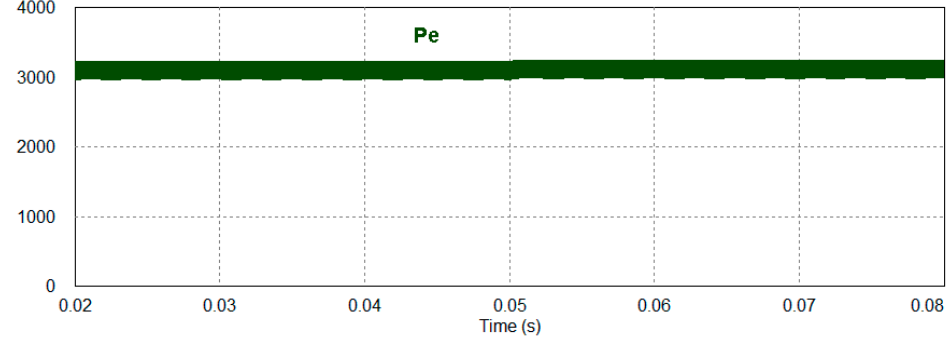
Figure 8. Electric power absorbed by the converter from AC source.